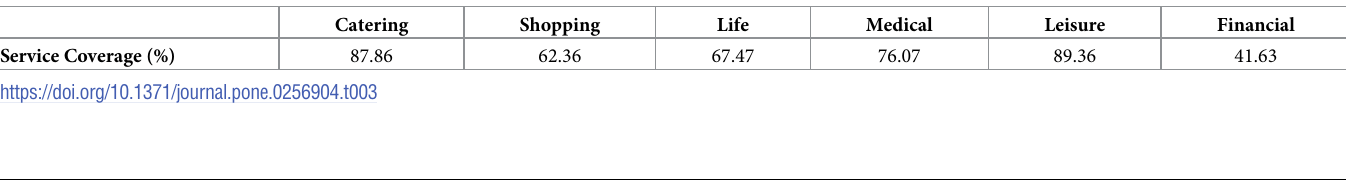
Table 3. Coverage rate of various basic service